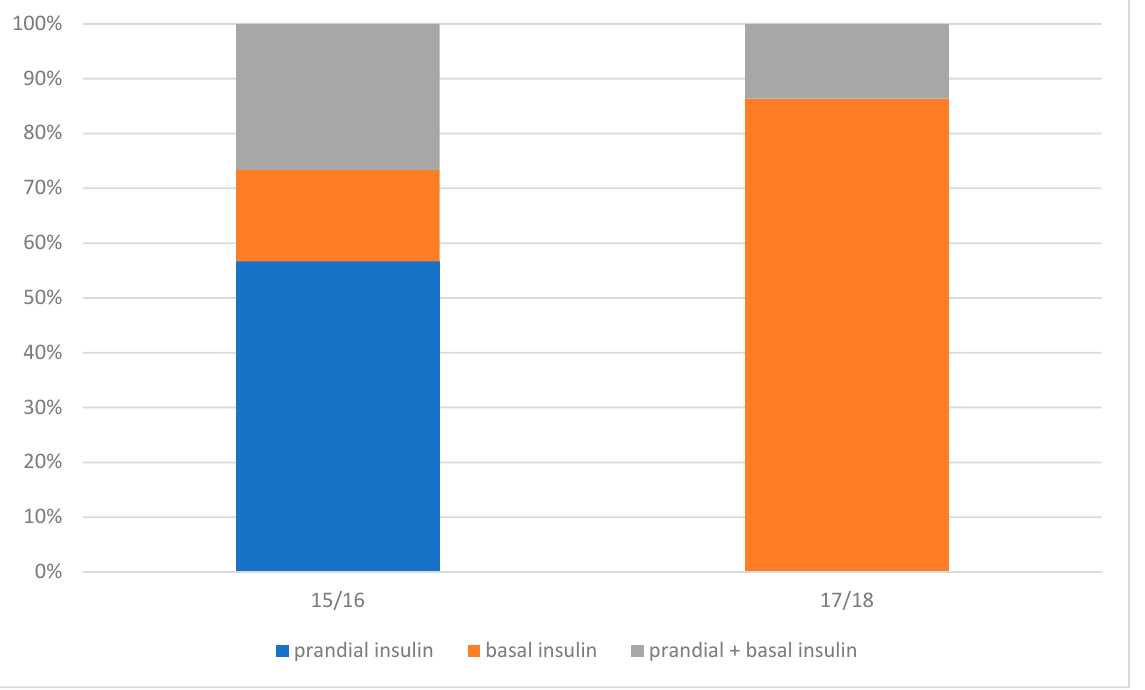
Figure 1. Mode of insulin therapy during pregnancy in groups 15/16 and 17/18. Furthermore, in Group-15/16, insulin was significantly more often used in older patients ( p = 0.019224) and in those with higher BMI values ( p = 0.037626), which was not found in Group-17/18 (Table 6). Table 6. The relationship between the mode of treatment and the age of patients and body mass index (BMI) values.